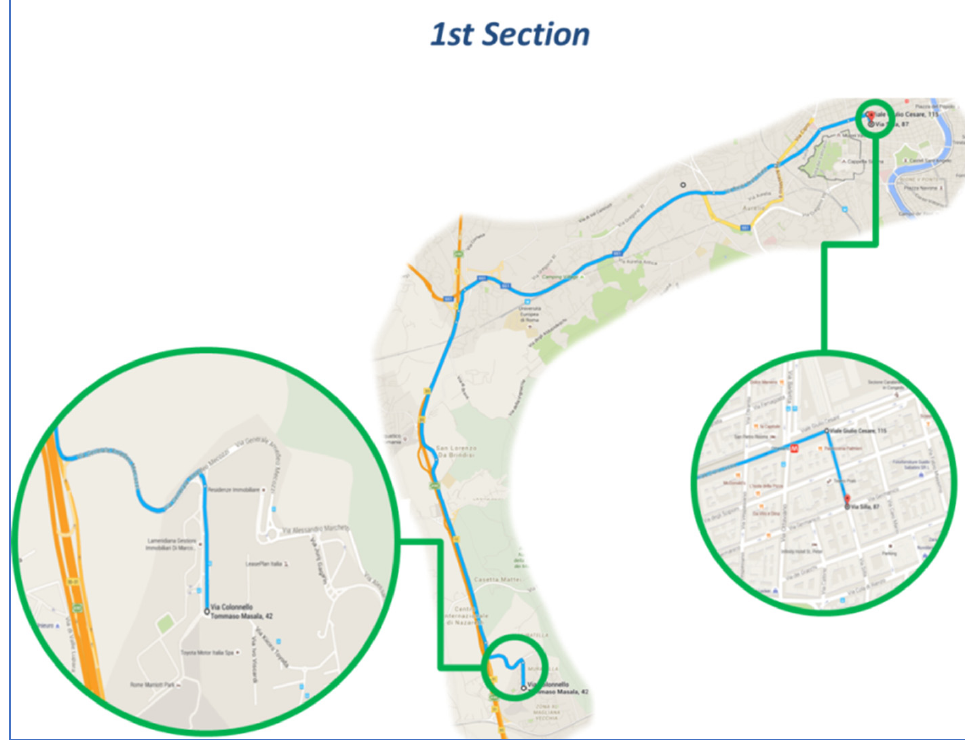
Figure 2. Outward: extra-urban and high-flow urban route.